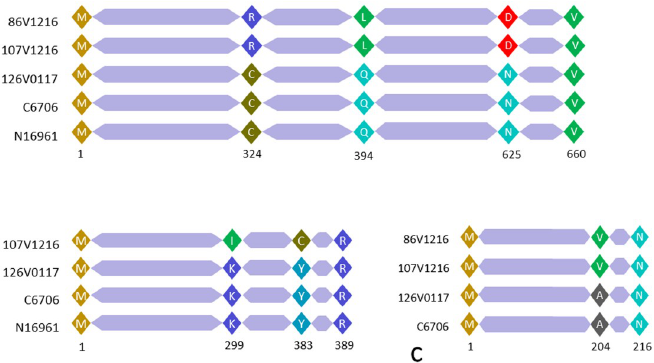
Fig 2. Multiple alignment of predicted amino acid sequences of (a) cqsS (b) cqsA and (c) HapR proteins. Strains 86V1216 and 107V1216 are AI-2 overproducing V . cholerae non-O1 non-O139 isolated from water samples, whereas strains C6706 and N16961, and 126V0117 are typical V . cholerae O1 and non-O1 non-O139 respectively. Notably, strain 86V1216 does not carry the cqsA gene encoding CAI-1 synthase, and strain N16961 does not have an active hapR gene due to a natural frame shift mutation [21].